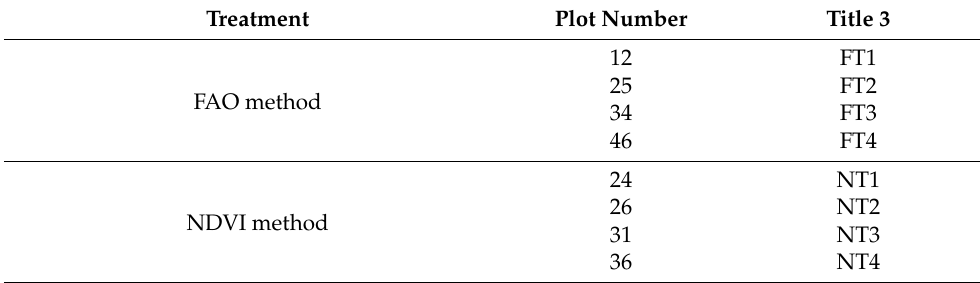
Table 1. Treatments and plot numbers for cotton 2007 experiment. Treatment Plot